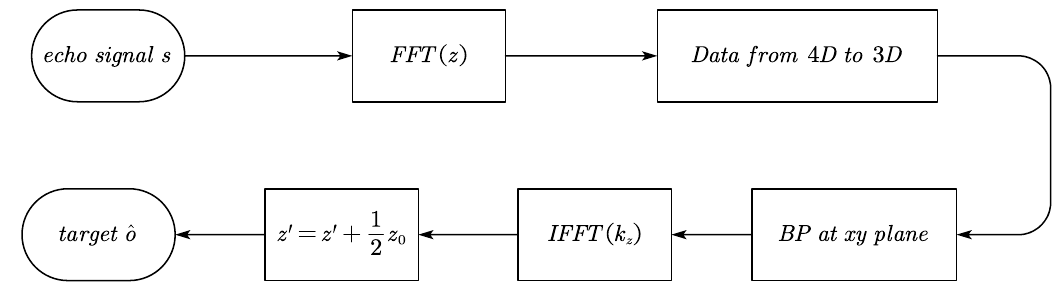
Figure 4. The main steps flow of the proposed algorithm.